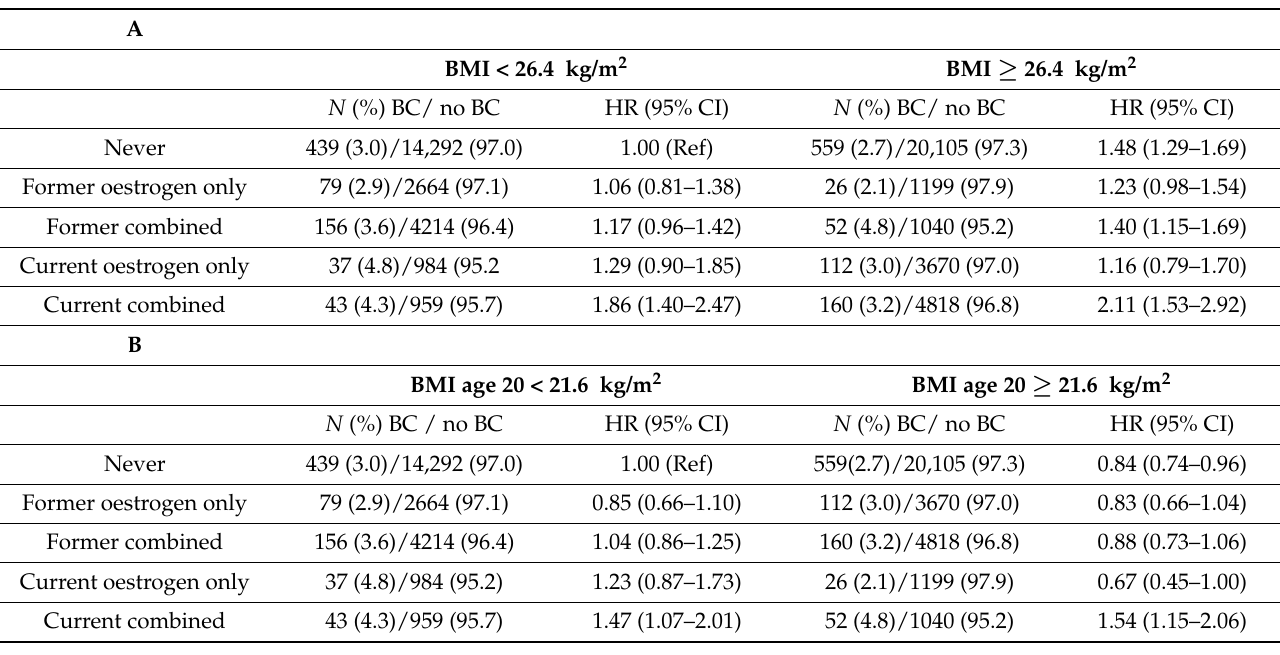
Table 3. MHT type and BC risk and current and early